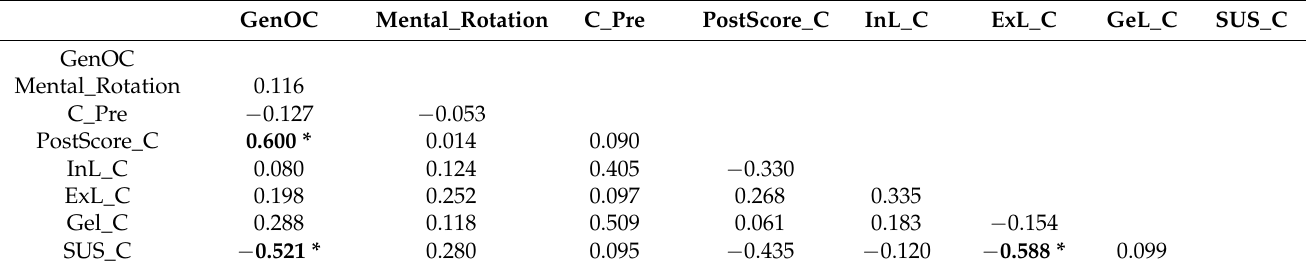
Table 6. Correlations for group two (AR) for the topic